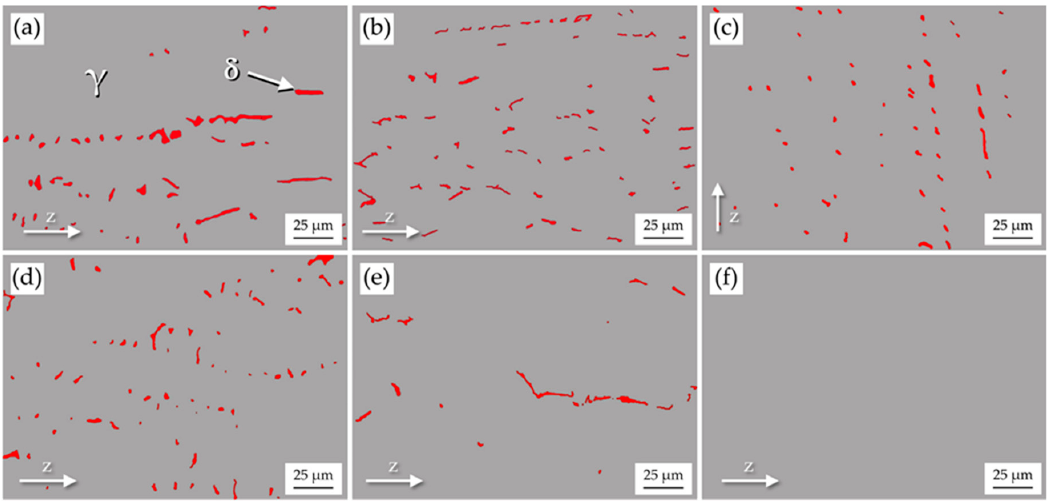
Figure 5. Processed OM images from the following specimens. ( a ) air-1.1; ( b ) air-2.2; ( c ) air-3.3; ( d ) argon-1.1; ( e ) argon-2.2; and ( f ) argon-3.3.